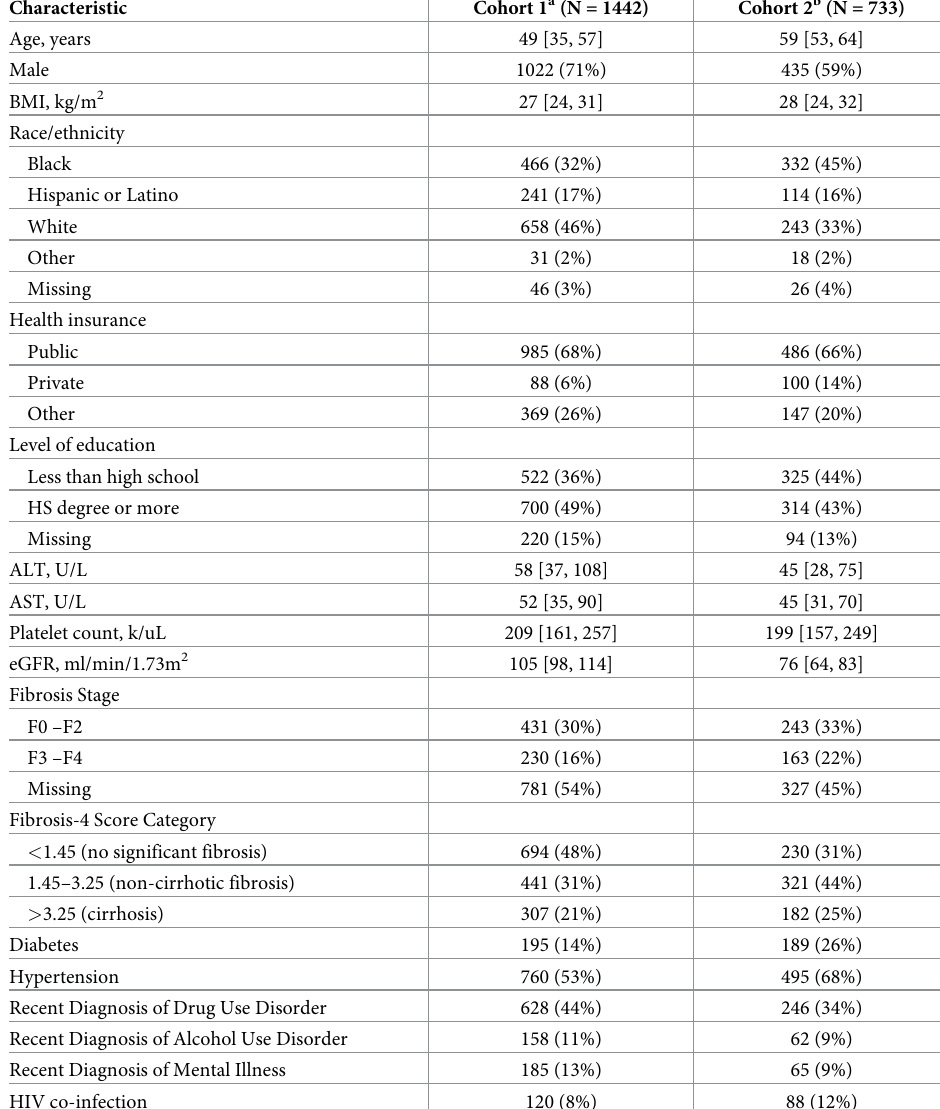
Table 1. Baseline characteristics stratified by cohort. Characteristic